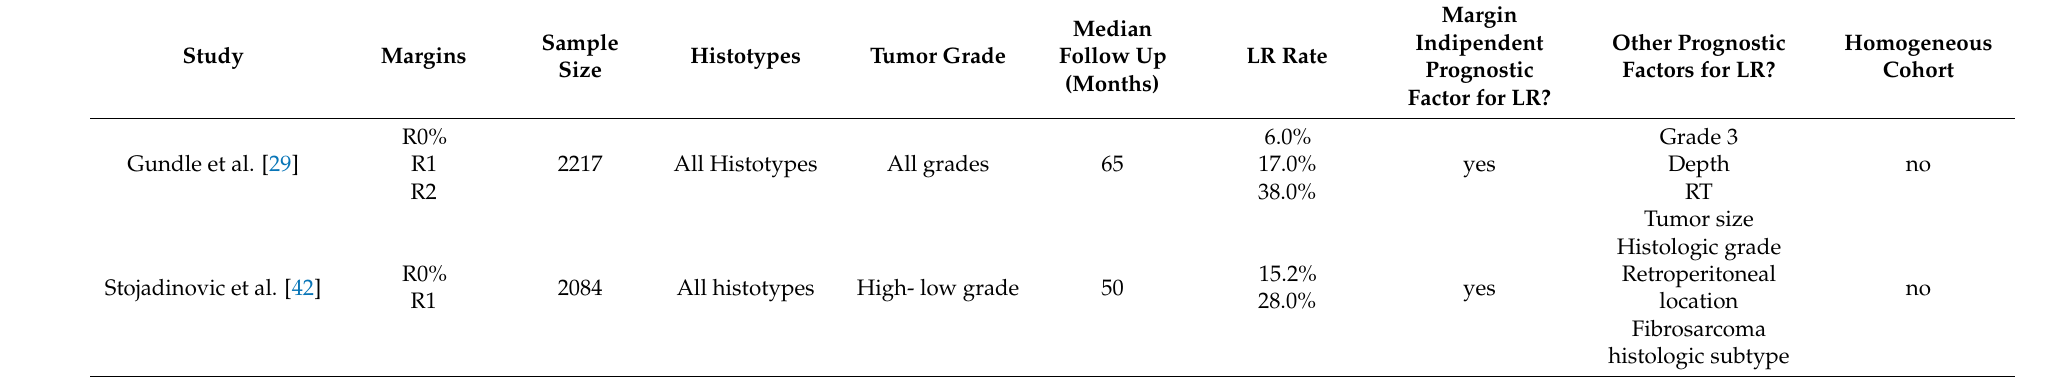
Table 3. Review of the literature. Studies reporting margins based on AJCC